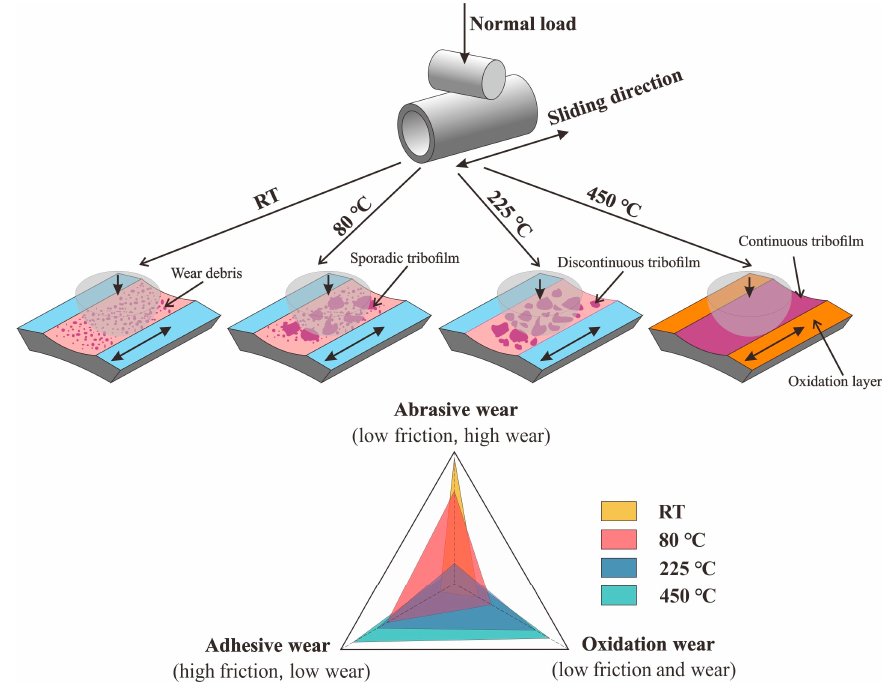
Figure 13. Schematic diagrams of the wear mechanisms.